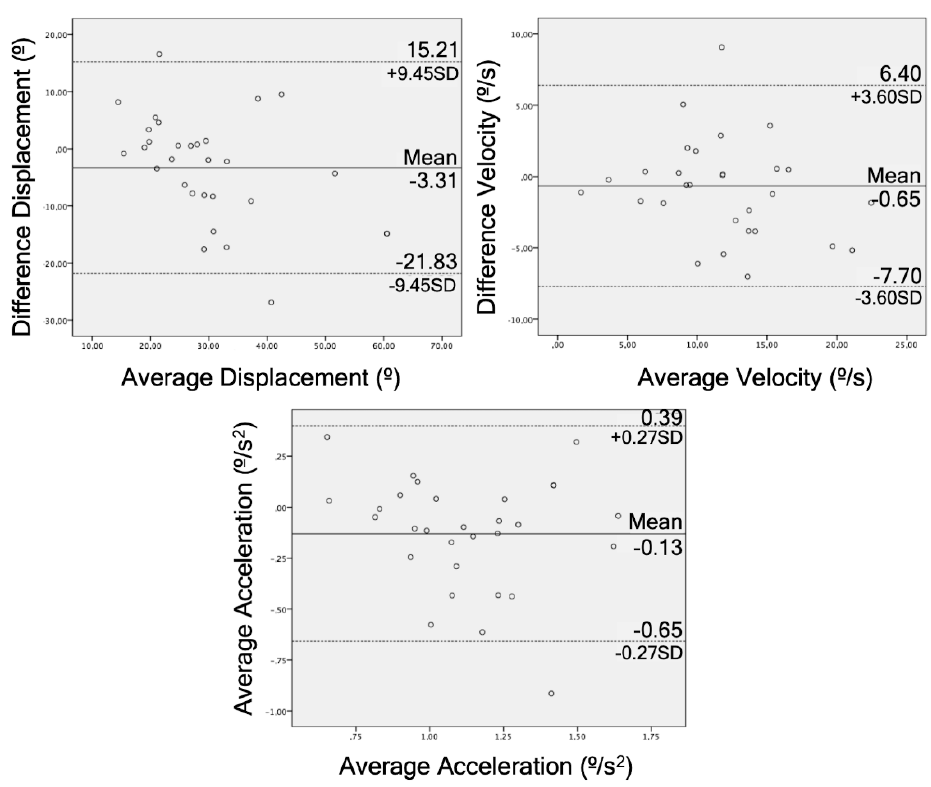
Figure 5. Bland–Altman plots for displacement, velocity, and acceleration in the STS test comparing the RGB-D camera and IMU. The lines represent the mean of the differences and limits of agreement.